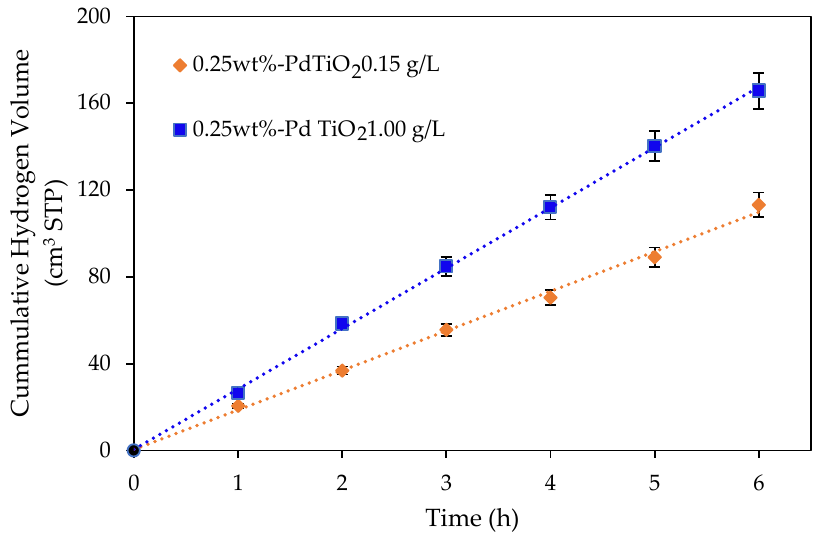
Figure 3. Cumulative hydrogen production using an undoped TiO 2 and a 0.25 wt% Pd-TiO 2 at catalyst concentrations of 0.15 and 1.00 g L − 1 . Conditions: 2.0 v / v % ethanol, initial pH = 4 ± 0.05 and 6 h under near-UV light. Note: at least three repeats per experiment were performed.